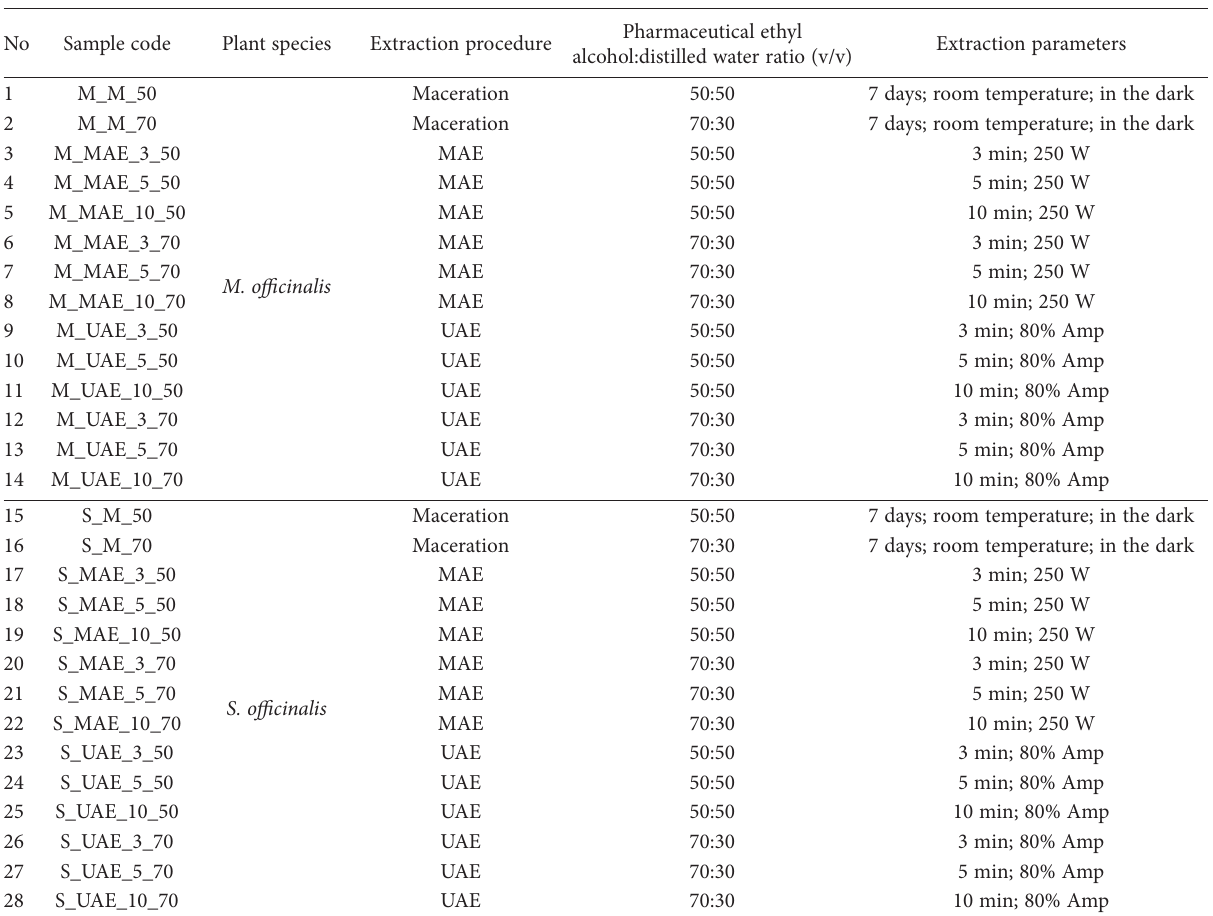
Table 1. Experimental variants used in this